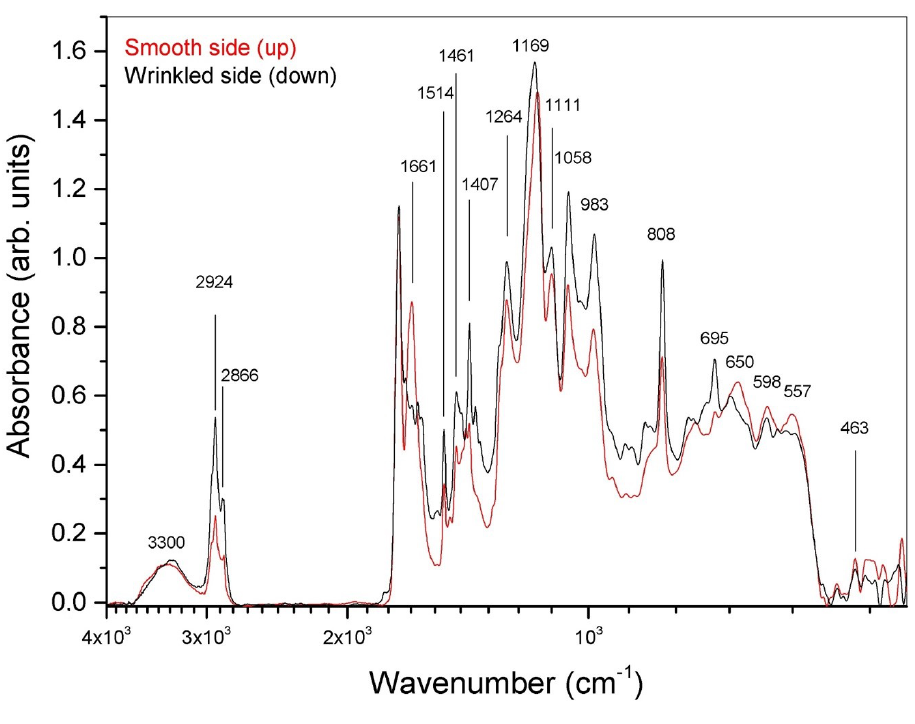
Figure 3. ATR-FTIR measurements operated on the upper and lower faces of the t-PMP film.